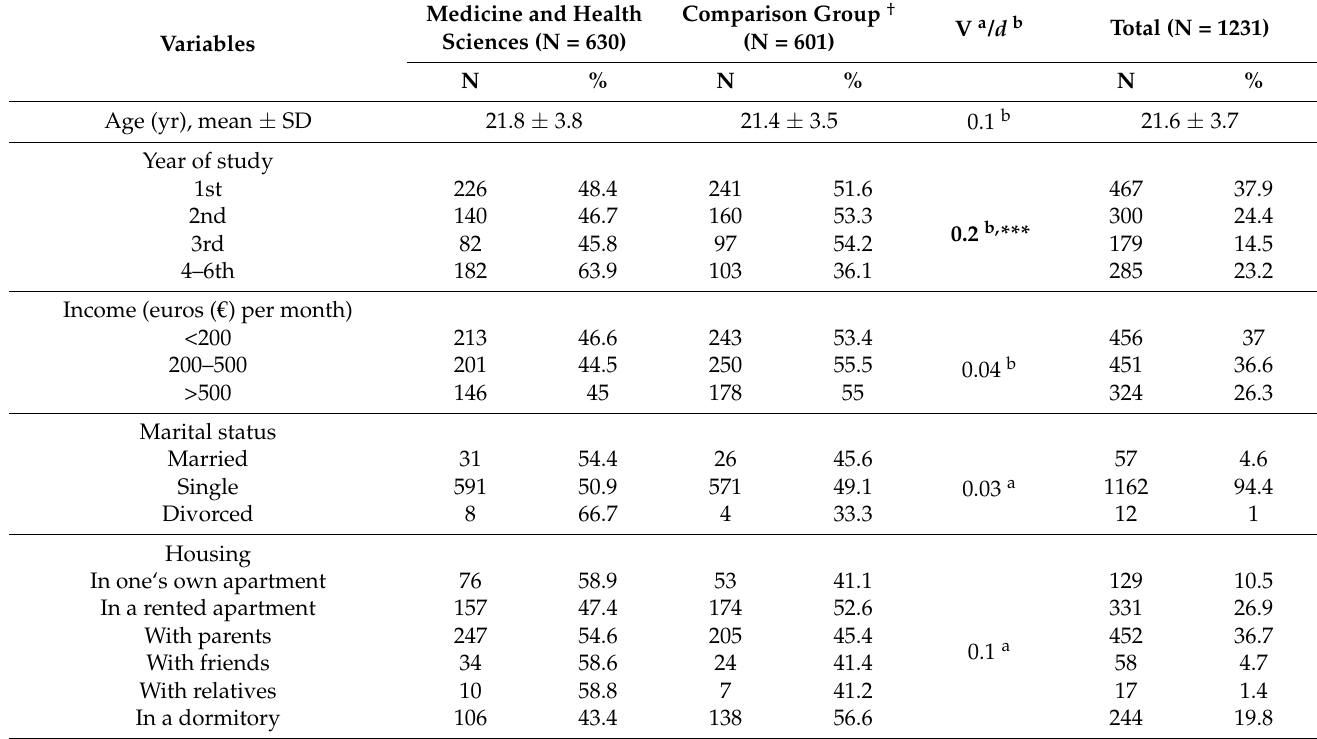
Table 2. Female students of medicine and health sciences by categorisation of demographic character- istics, habitual physical activity, somatic symptoms and symptomatology of anxiety and